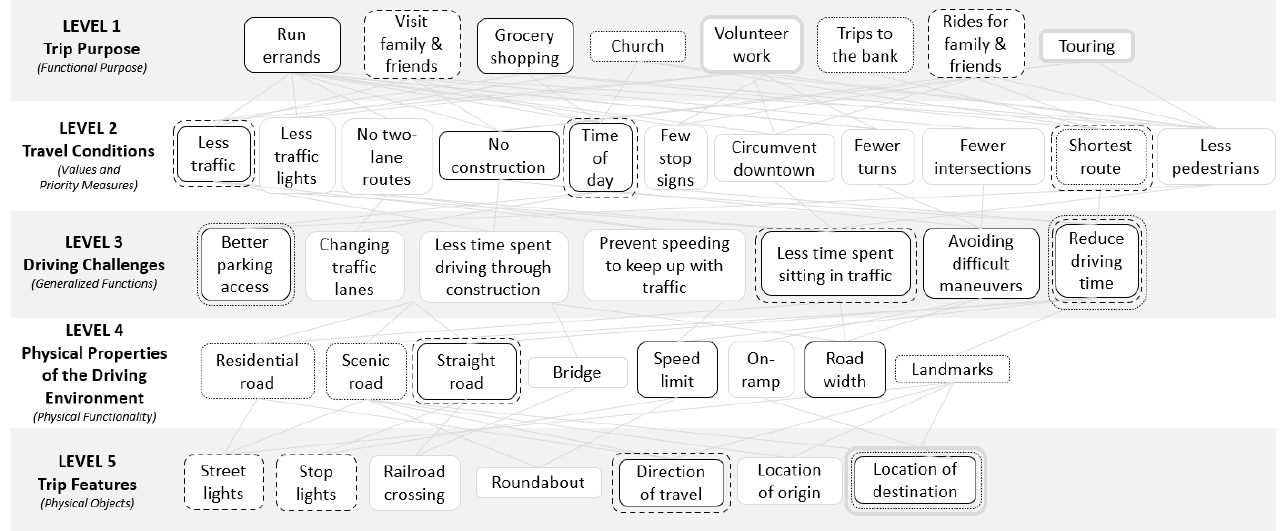
Figure 2. Summary of the route familiarity abstraction hierarchy